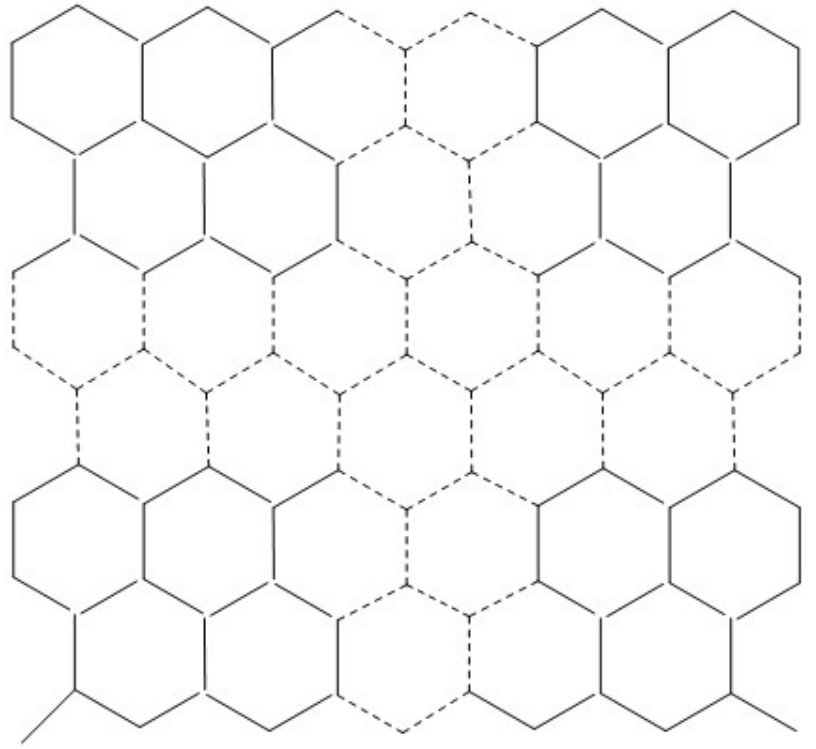
Fig. 8 Quadrilateral section P n